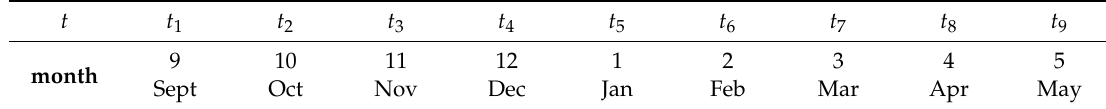
Table 2. The month corresponding to t = t 1 , ... , t T − 1